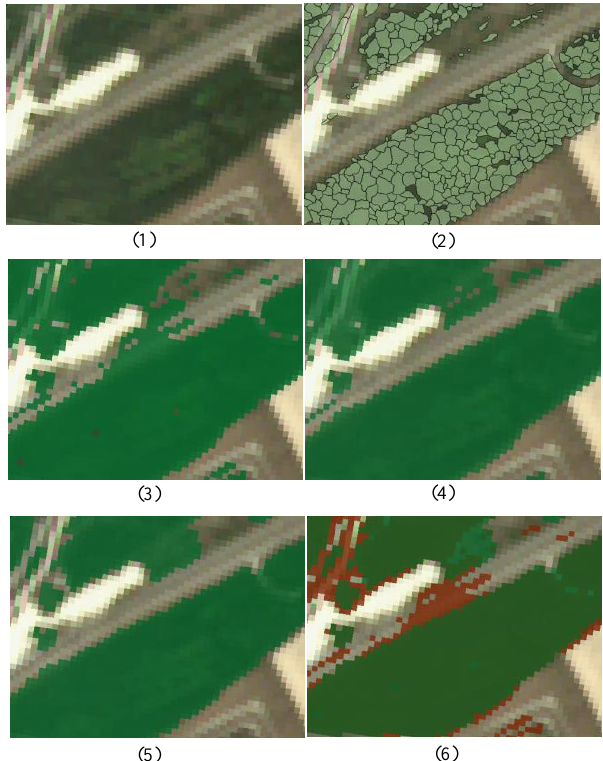
Figure 9: (1) Sentinel-2 L2A cloud-free mosaic over Mailly, France, and (2) corresponding ground truth, (3) prediction from a single image, (4) multi-date extraction, (5) final result and (6) comparison between (3: orange) and (5: green).